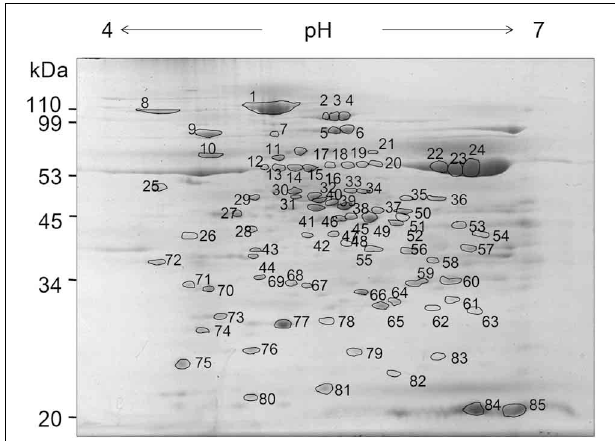
FIGURE 2 | Two-dimensional electrophoresis of spinach chloroplast envelope proteins. Chloroplast envelope proteins (200 µ g) were loaded onto the focusing gel (pH 4–7), resolved by 2-D PAGE and visualized by colloidal blue staining. A total of 85 protein spots from this map were excised, digested, and analyzed by MALDI-ToF to yield a peptide mass fingerprint for databases searching. Numbers indicate spot numbers. Apparent molecular weight (Mr) in kDa are indicated on the